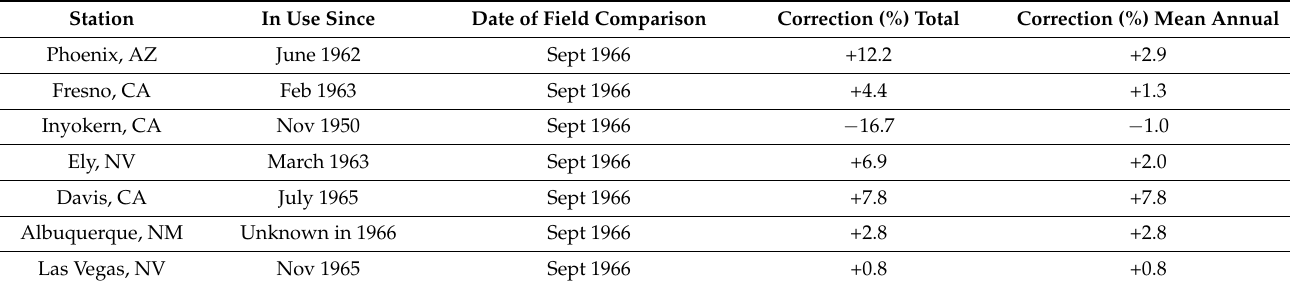
Table 4. Selected USA sites and calibration of solar instruments (data from [19]).